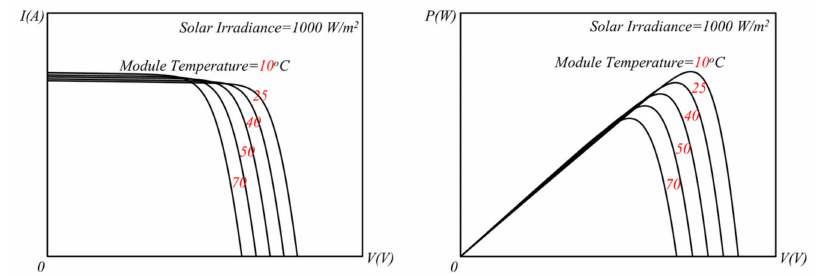
Figure 6. Effect of temperature on the solar cells